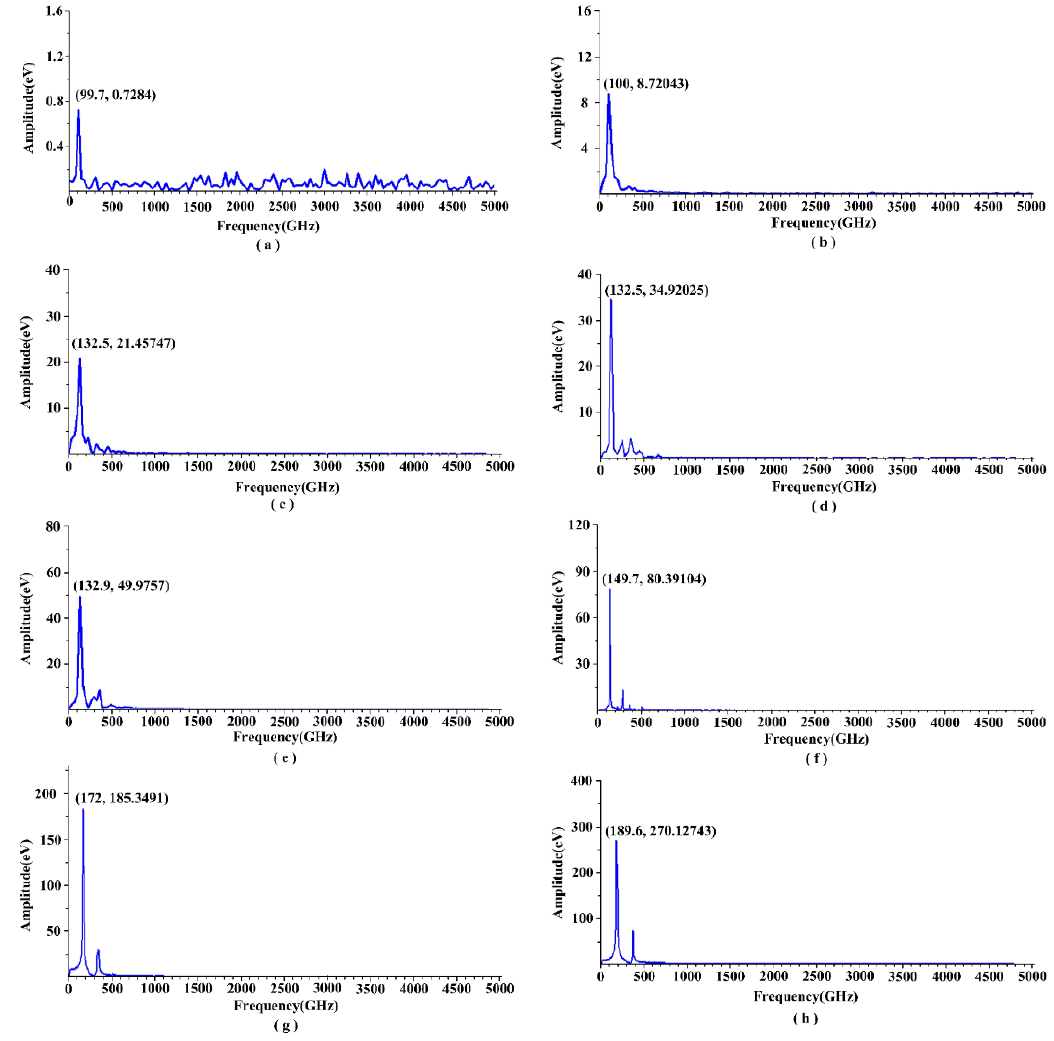
Figure 6. Amplitude versus frequency for external forces of ( a ) 1.768 nN; ( b ) 7.072 nN; ( c ) 15.912 nN; ( d ) 28.288 nN; ( e ) 44.2 nN; ( f ) 63.648 nN; ( g ) 86.638 nN; and ( h ) 113.152 nN.